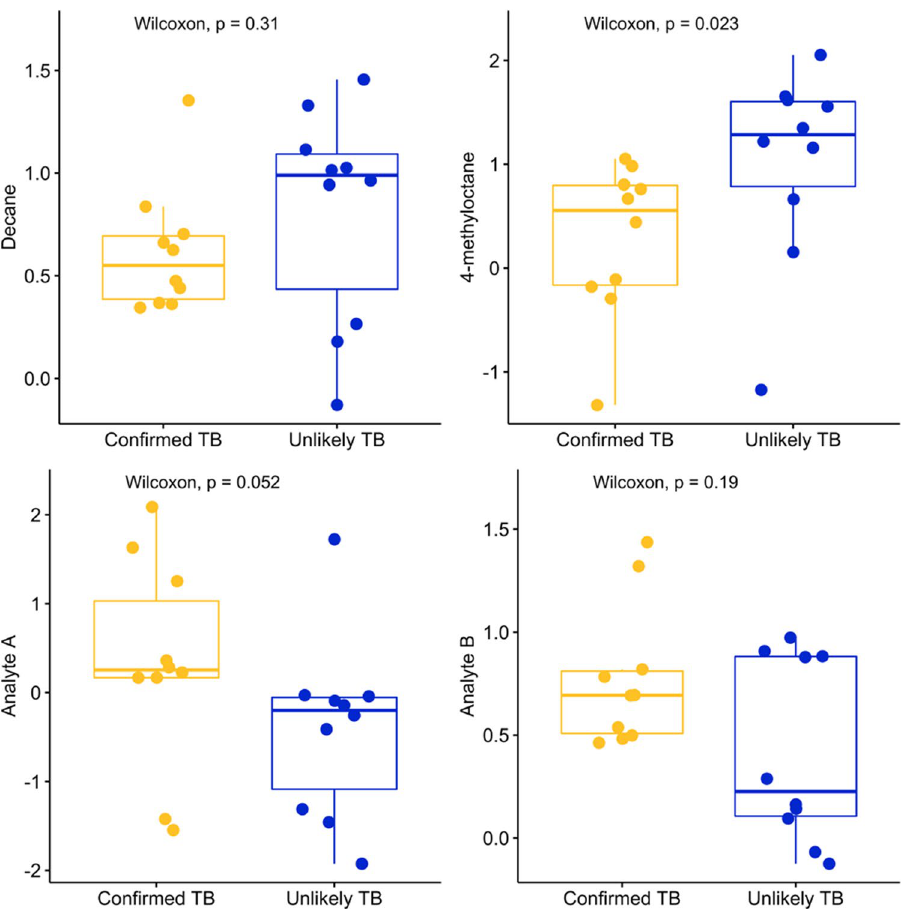
Figure 1. The distribution of the mean centered and normalized peak area of each of the four compounds selected in the breathprint across confirmed TB and unlikely TB patients. For each compound, the median observed peak area between the two groups is different, indicating univariate differences which may contribute to the discrimination of confirmed TB patients from unlikely TB patients. Boxplots show the quartiles of the data (first line is the first quartile, midline is the median, third line is the third quartile) where whiskers represent 1.5 × IQR (inter-quartile range). The distribution across all three TB groups is shown in Supplementary Fig. 2. Figure created in R 73 using ‘ggplot2’ 84 and ‘ggpubr’ 85